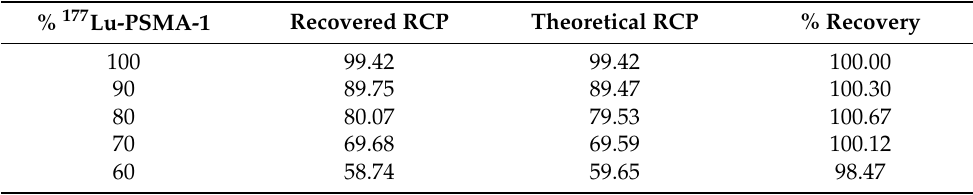
Table 4. Accuracy with % recovery in TLC.